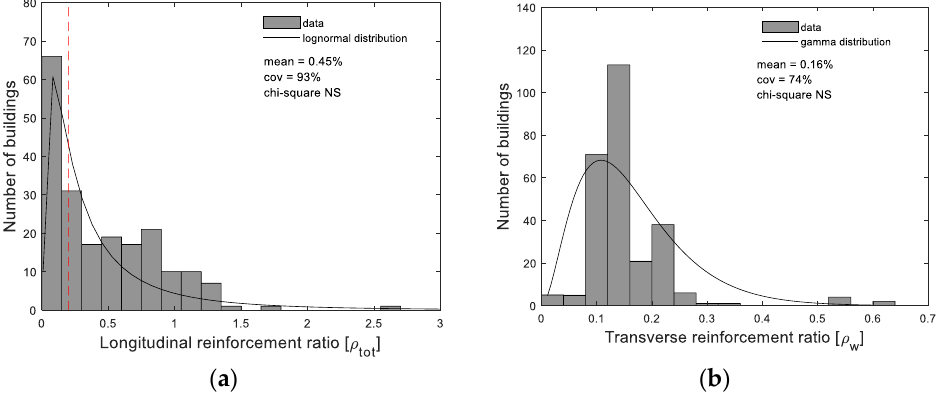
Figure 18. Distribution of buildings regarding RC walls′ ( a ) longitudinal reinforcement ratio (%) and ( b ) transverse reinforcement ratio (%) .